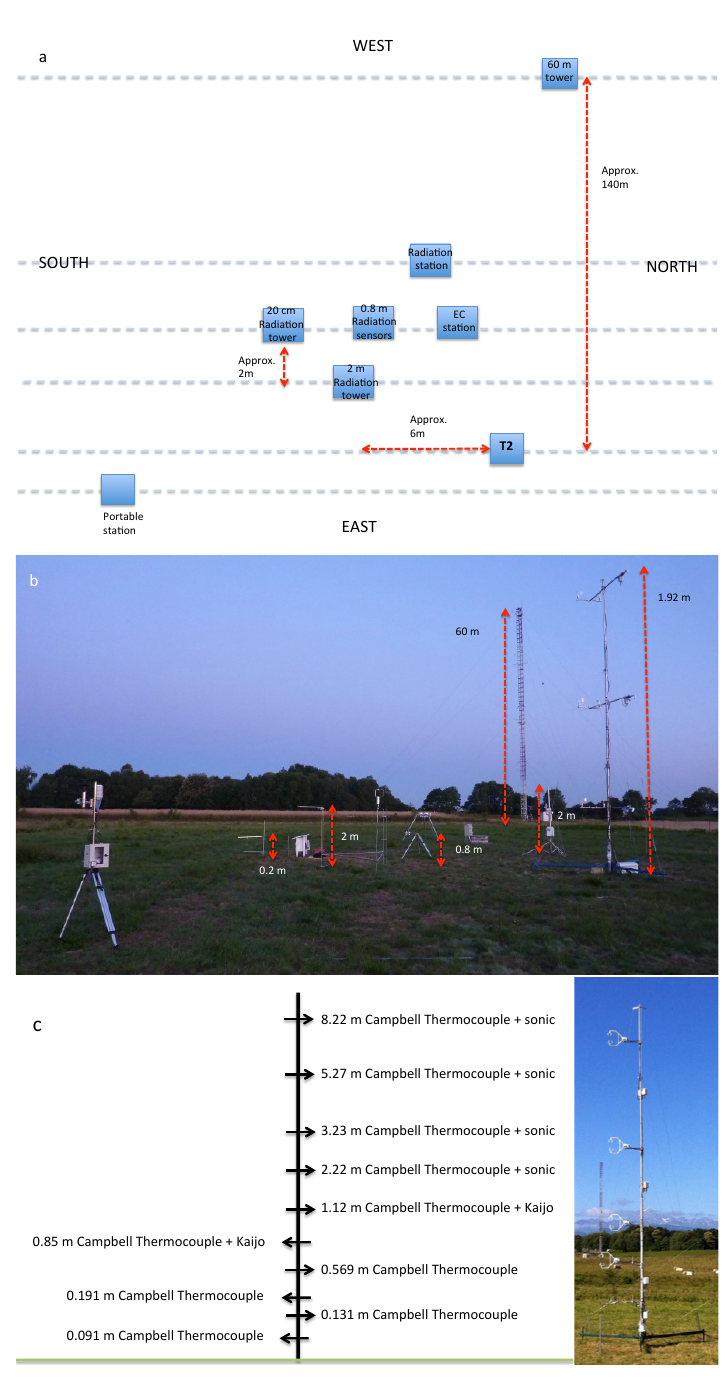
Figure 1. (a) Schematic horizontal view illustrating the location of the instrumentation around T2, (b) photograph (looking west) showing the instruments around T2, and (c) photograph (looking south) showing the instruments around the T1 mast.